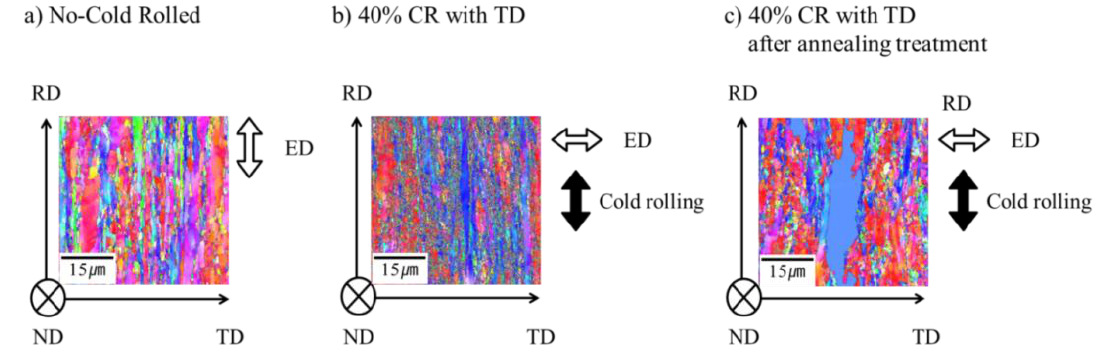
Figure 10. Grain morphology on ND surface in Al-free ODS steel; ( a ) as-extruded, ( b ) extruded and 40% cold rolled in the TD and ( c ) extruded, 40% cold rolled and annealed at 1000 °C for 1 h.